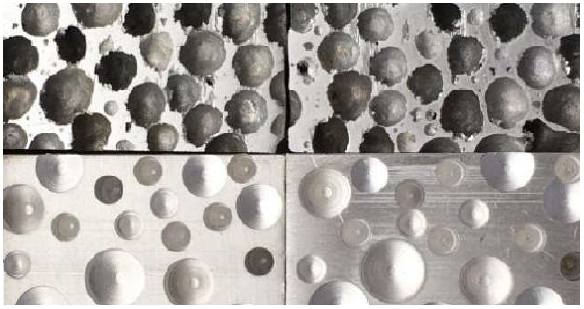
Figure 2. Holes comparison of the aluminum foam and aluminum-foam-like.